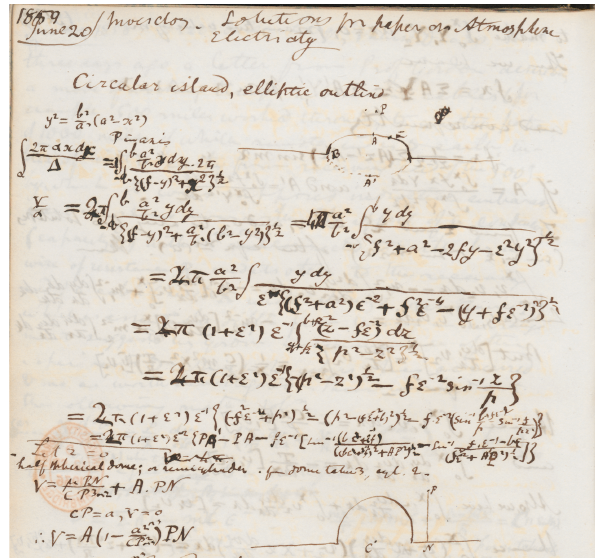
Figure 7. Excerpt from Notebook 35 (Thomson, 1859e), dated 20 June 1859 and written at Invercloy (top left), showing Kelvin’s cal- culations and sketches of the electric field distortion due to moun- tains and